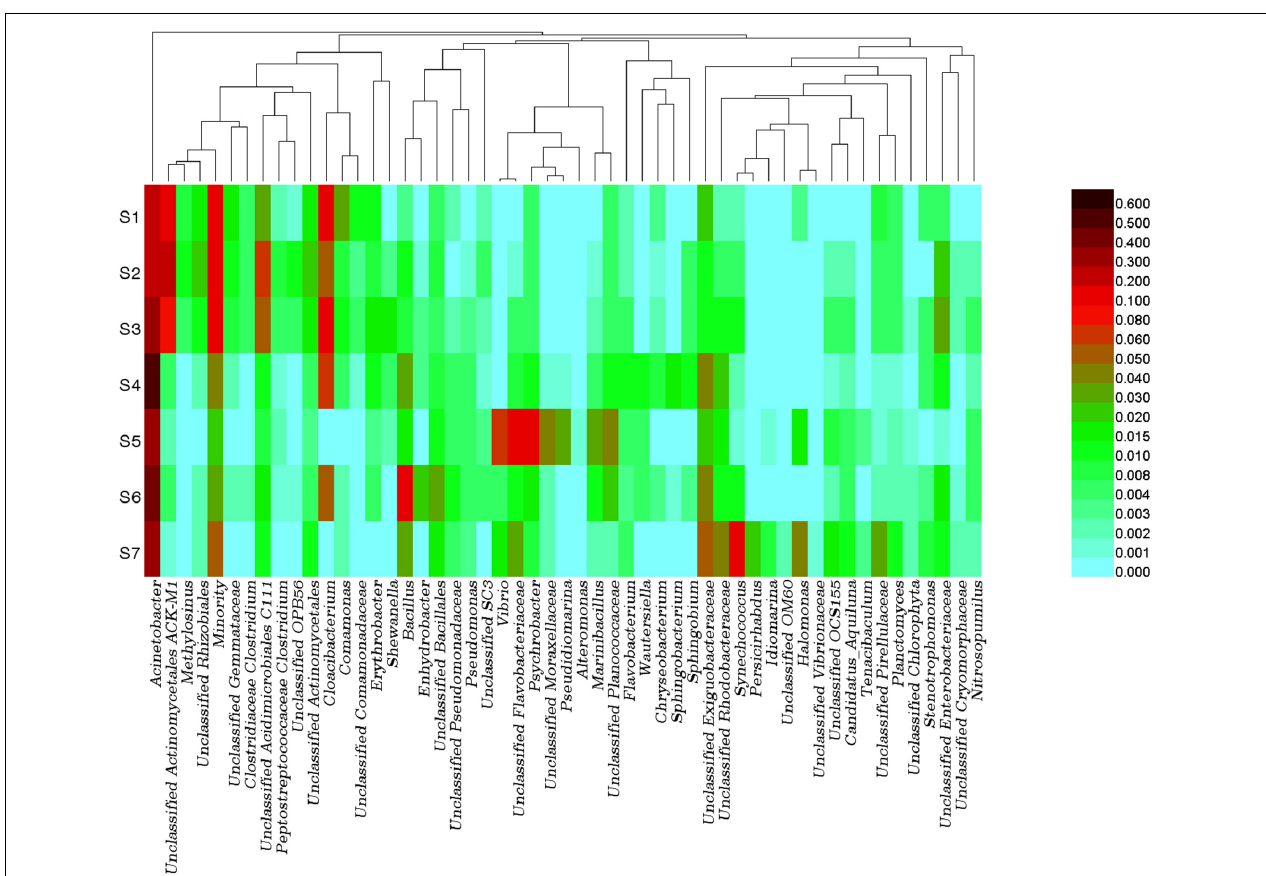
FIGURE 3 | Bacterial community compositions in water from sampling sites. Relative abundance of the dominant bacterial genus (threshold value: at least one site with bacterial percentage greater than 1%). The color scale indicated the relative abundances of bacterioplankton at each station.